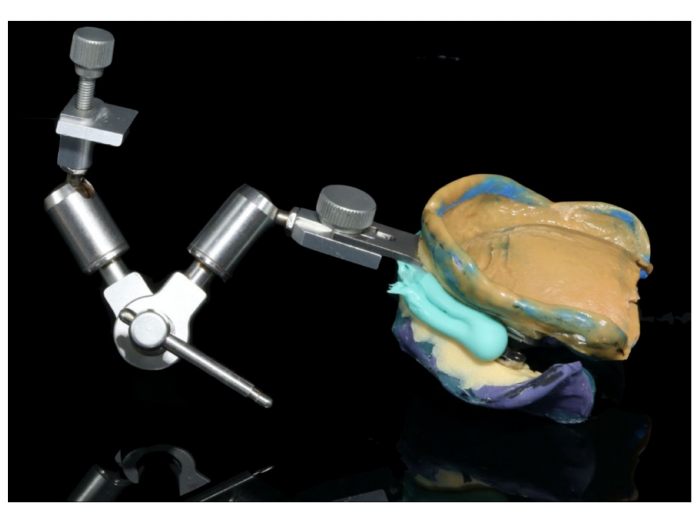
Figure 6. Functional impressions of the upper and lower jaw in combination with centric registration and face bow